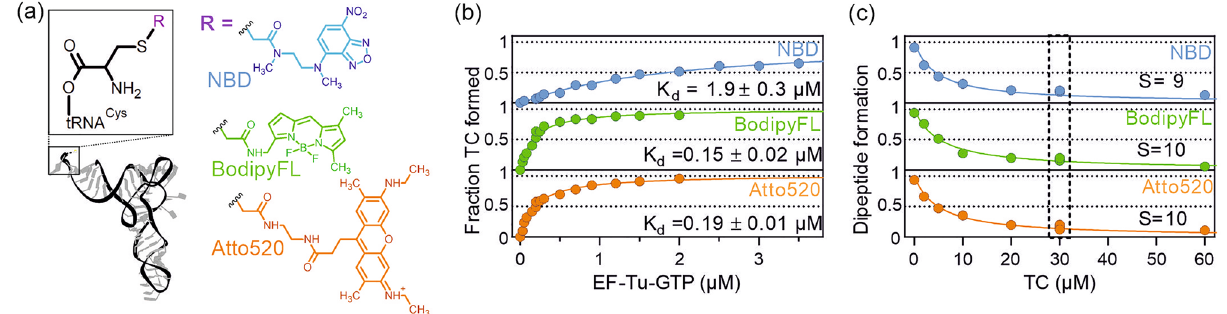
Figure 1. Ternary complex formation with RCys-tRNA and incorporation of RCys into dipeptides. ( a ) Chemical structures of fluorescent probes covalently attached to the amino acid side-chain thiol group to form RCys-tRNA Cys . ( b ) TC formation with RCys-tRNA Cys (10 nM) upon addition of increasing concentrations of EF-Tu–GTP monitored by the fluorescence change of the R probe (Figure S2). Data were normalized by setting the fluorescence intensity of RCys-tRNA Cys in the absence of EF-Tu–GTP to 0 and the saturating fluorescence intensity extrapolated by hyperbolic fitting to 1. Lines represent hyperbolic fits using a one site binding model (Material and Methods). The K d value is reported with the standard error of the fit. ( c ) Formation of f[ 3 H] Met-RCys dipeptides on 70S IC (20 nM) in the presence of RCys-tRNA Cys (0.12 µM), EF-Tu–GTP (75 µM), and increasing concentration of E. coli aa-tRNA without Cys-tRNA Cys . f[ 3 H]Met-RCys peptides were